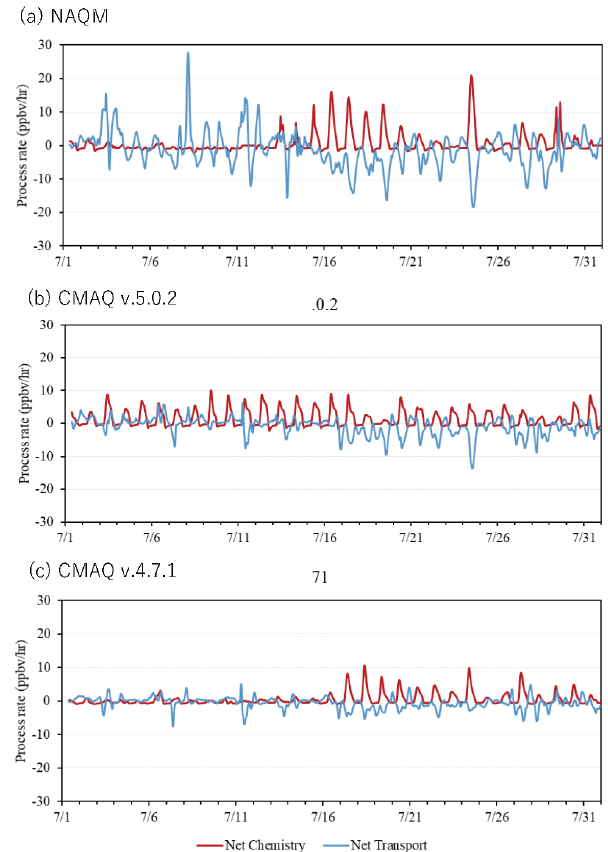
Figure 6. Model-calculated net chemical production and net trans- port of O 3 at Oki in July 2010 by (a) NAQM, (b) CMAQ5.0.1, and (c) CMAQ